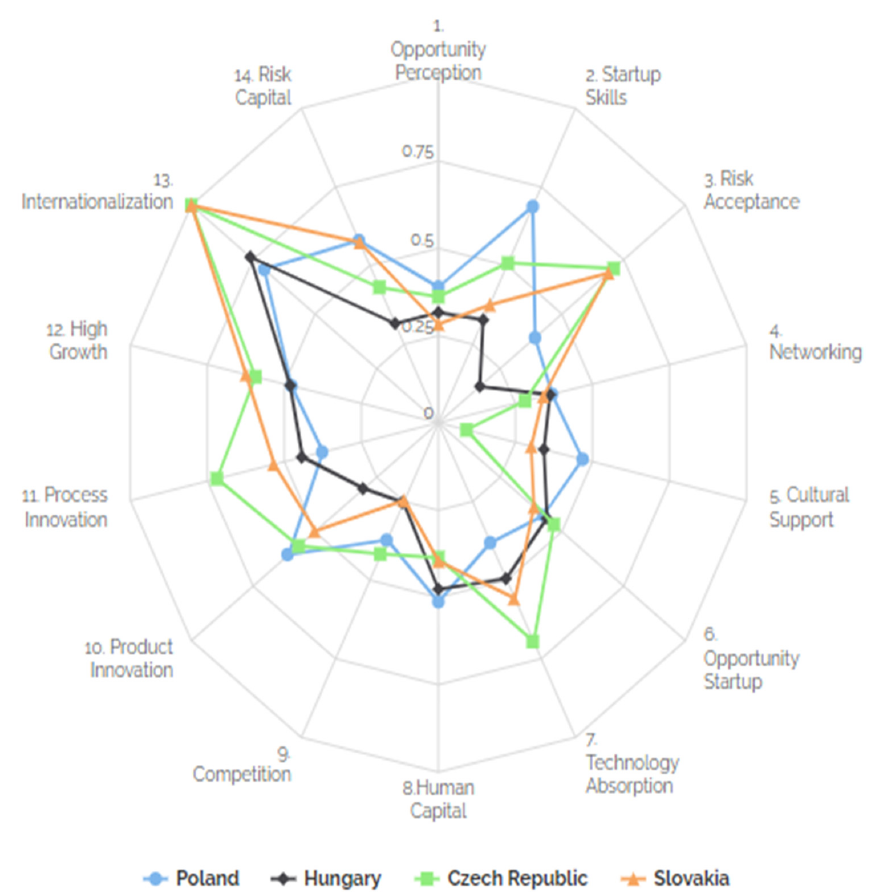
Figure 11. Sub-indices of the International Entrepreneurship Development Index, breakdown for the year 2020 [47].